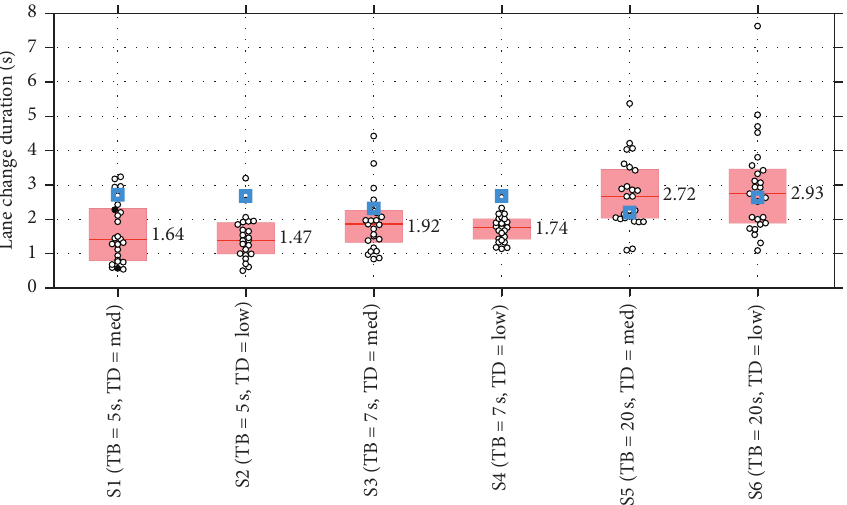
Figure 8: Boxplots of the lane change duration for the six scenarios. White circles represent noncollision trials (MTTC > 0s); black circles represent collision trials (MTTC � 0s). The blue markers represent the values of the trajectory planner. Boxes capture the 25 th to 75 th percentiles, and the red line marks the median. The numbers next to each box represent the means of